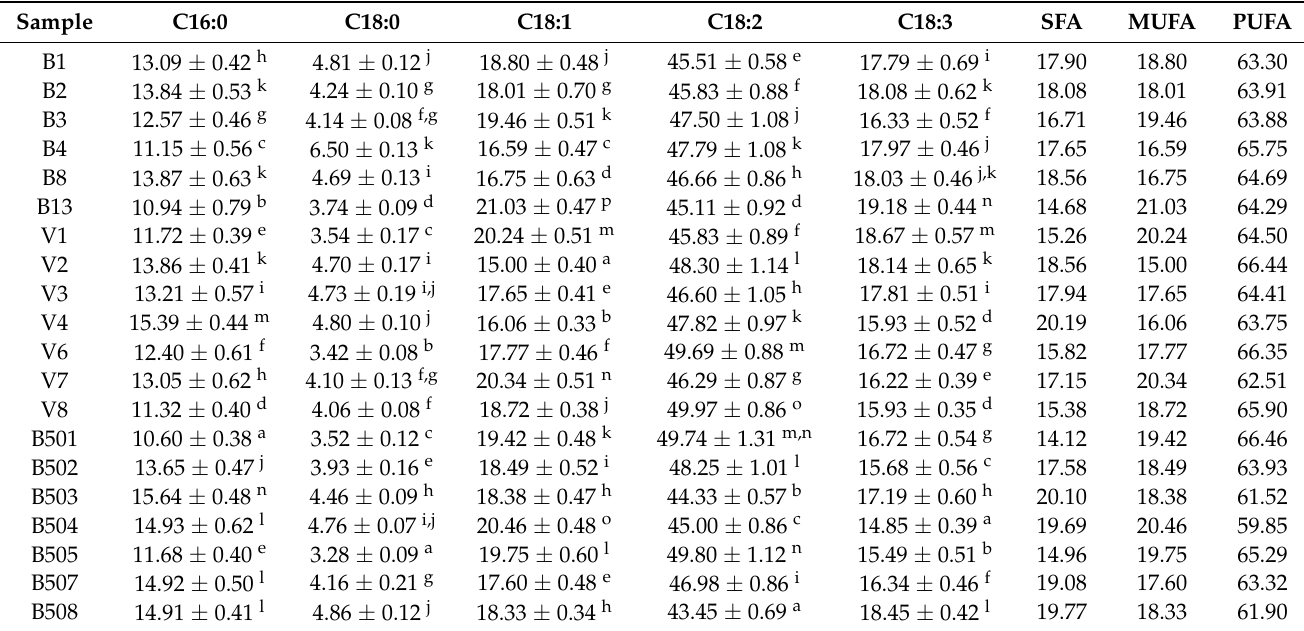
Table 6. Fatty acids content in walnuts